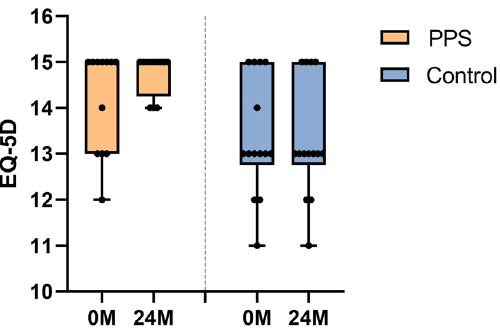
Figure 4. Changes in EQ-5D total score between 0 M (before trial) and 24 M (2 years after trial initiation) in each group. Group mean is shown with a line, and whiskers represent the min to max.